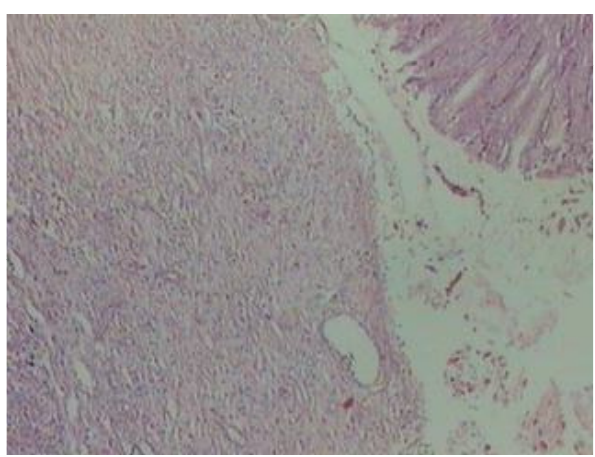
FIGURA 4 - Neoformação capilar discreta SGO7